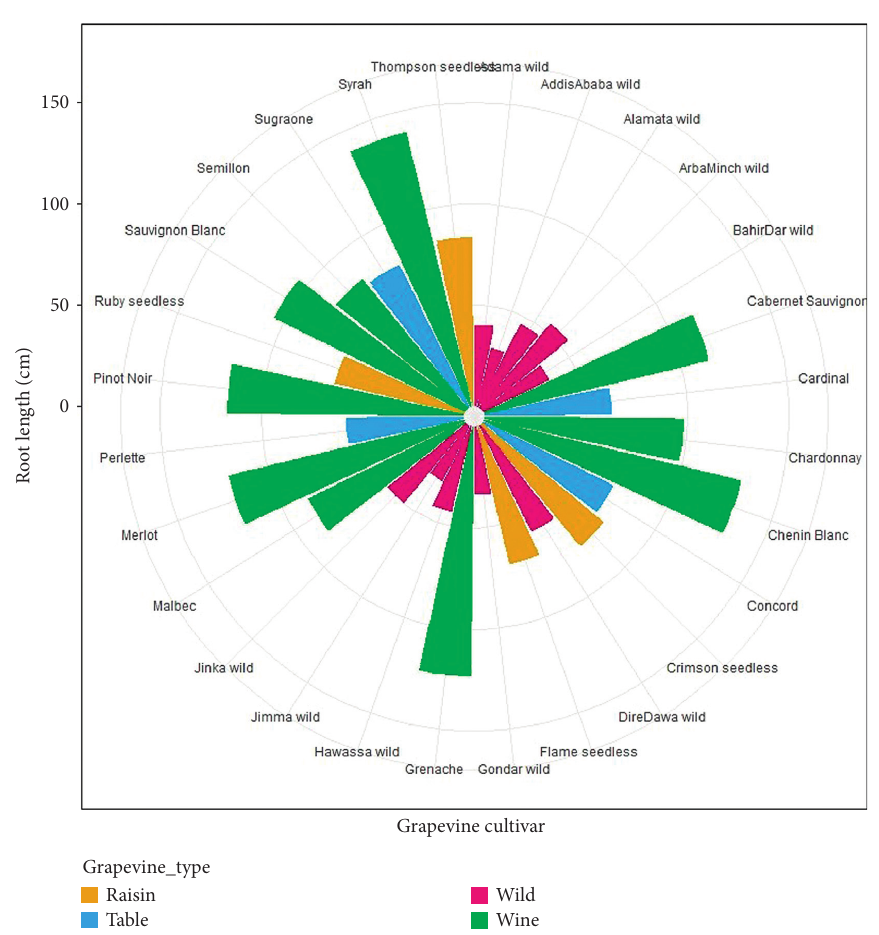
Figure 6: Grapevine root lengths among grapevine cultivars and grape